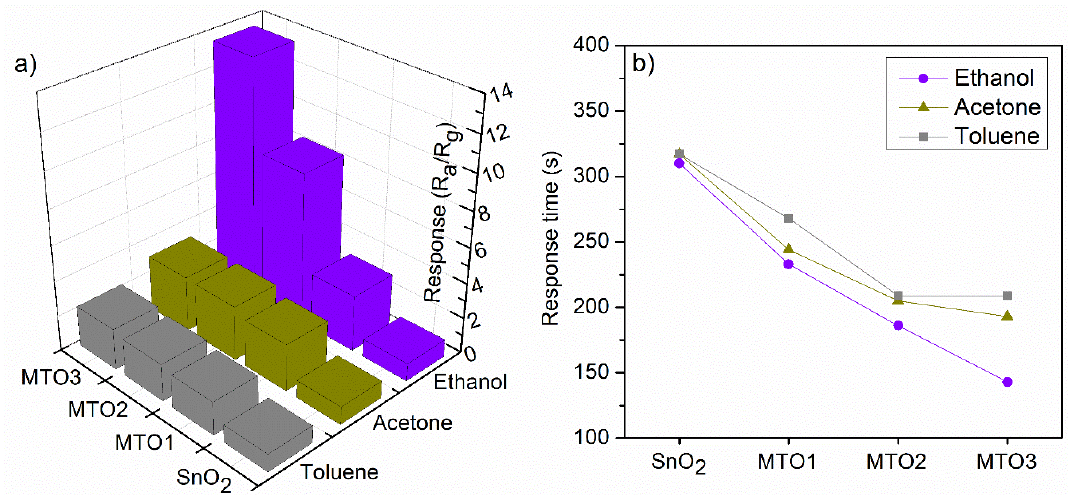
Figure 7. Response ( a ) and response time ( b ) towards 80 ppm of ethanol, acetone, and toluene for the non-doped and Mg-doped SnO 2 films.